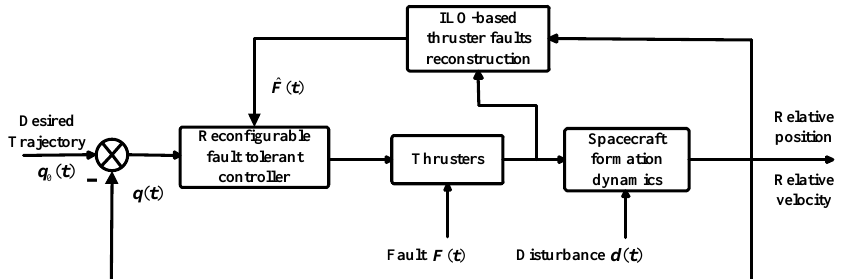
Figure 2. The proposed control framework for maintaining the formation configuration.